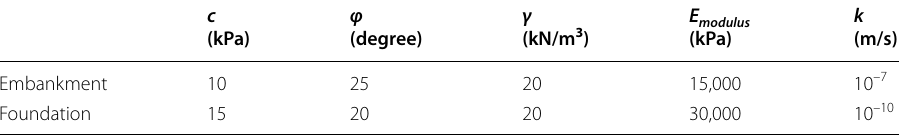
Table 1 Material properties used in the finite element simulation of hydraulic fracturing of homogeneous earthen dam c (kPa) * c Cohesion, φ Angle of internal friction, γ Unit weight, E modulus Elastic modulus, and k Saturated hydraulic conductivity